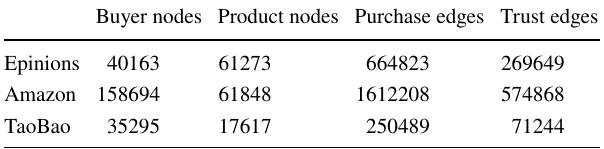
Table 2 Statistics of